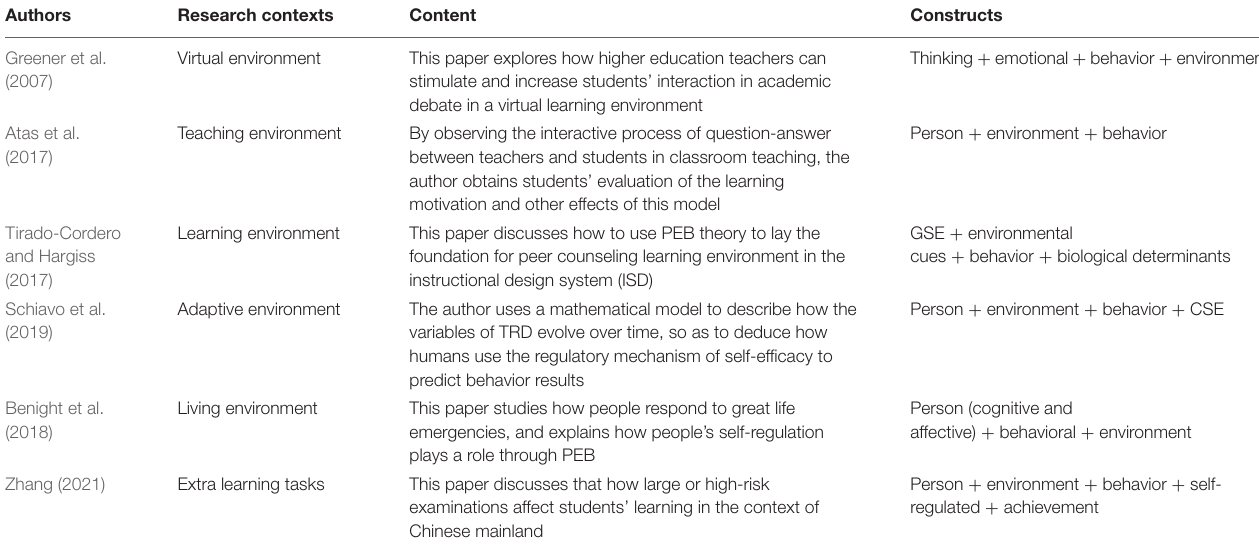
TABLE 1A | Triadic reciprocal determinism (TRD)-related